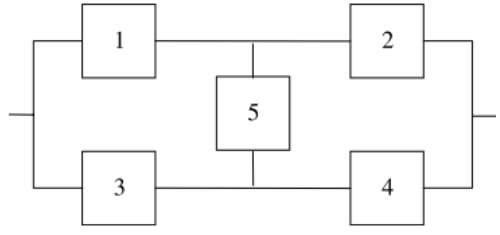
Figure 3. A complex (bridge) system.